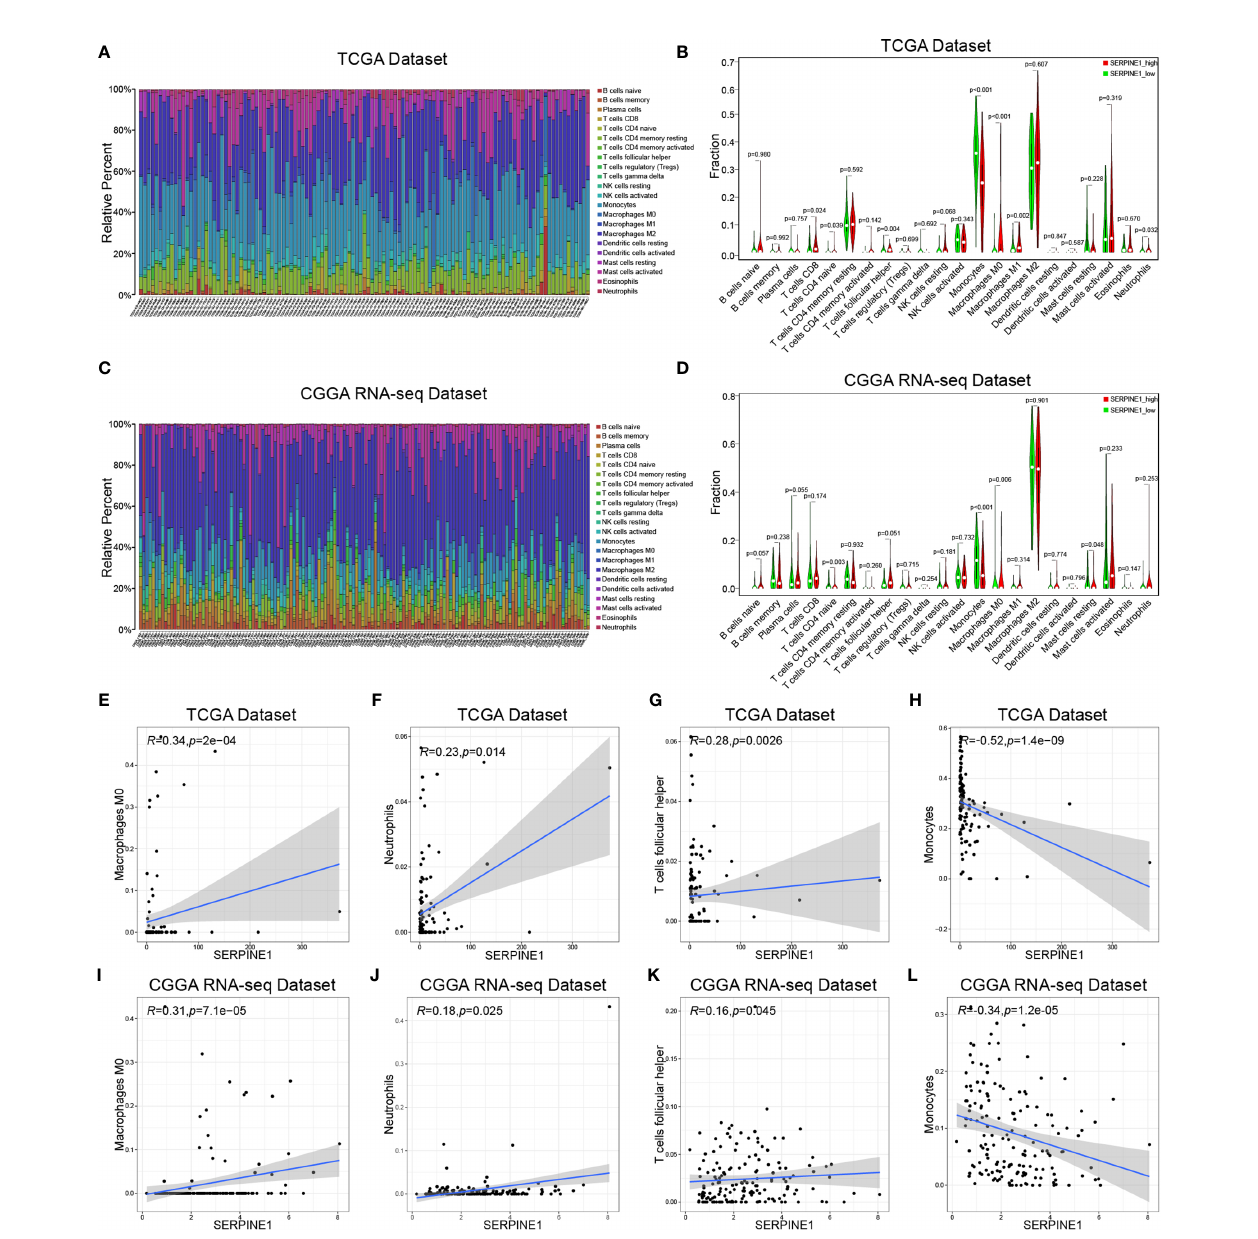
FIGURE 7 | SERPINE1 regulated the in fi ltration of immune cells in the LGGs. The immune in fi ltration landscape of LGGs: (A, C) bar plots showing the proportion of 22 immunocyte types in TCGA dataset and CGGA dataset. (B, D) Violin plots showing the differences in the proportion of 22 immunocyte types between SERPINE1 high and low expression groups. Red colors represented the group with SERPINE1 high expression; green color represented the group with SERPINE1 low expression. The SERPINE1 expression was positively correlated with the in fi ltration of M0-type macrophages (E, I) , neutrophils (F, J) , follicular helper T cells (G, K) , and negatively associated with monocytes (H, L) . P-value < 0.05 was considered statistically signi fi